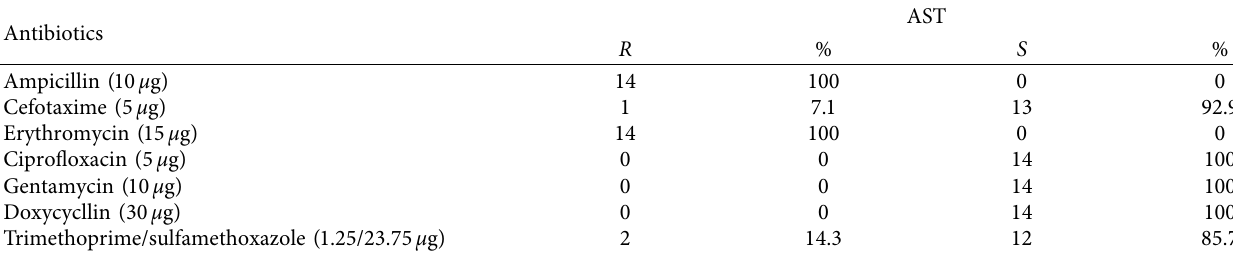
R � resistant , S � sensitive .